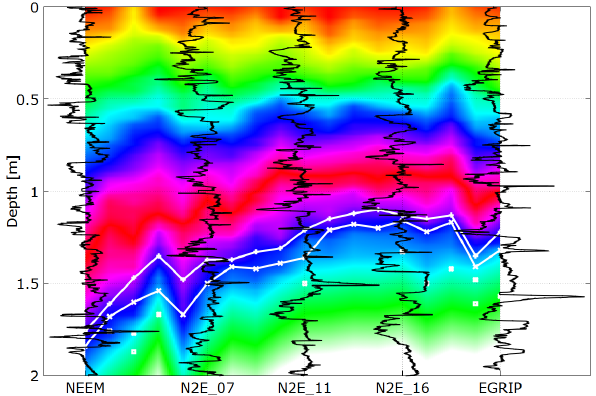
Figure 6. Continuous depth alignment, example density profiles and melt layers. A color map was applied uniformly at the first site (NEEM) and then transformed the same way as the depths were assigned. Thus snow within the same color band was matched dur- ing the fitting process. Linear interpolation was used between the sampled sites. In black, measured density profiles for the labeled locations are shown at the same scale, centered around their respec- tive mean values. The white lines and points indicate the melt layer positions detected from the CT scans (cf. Table